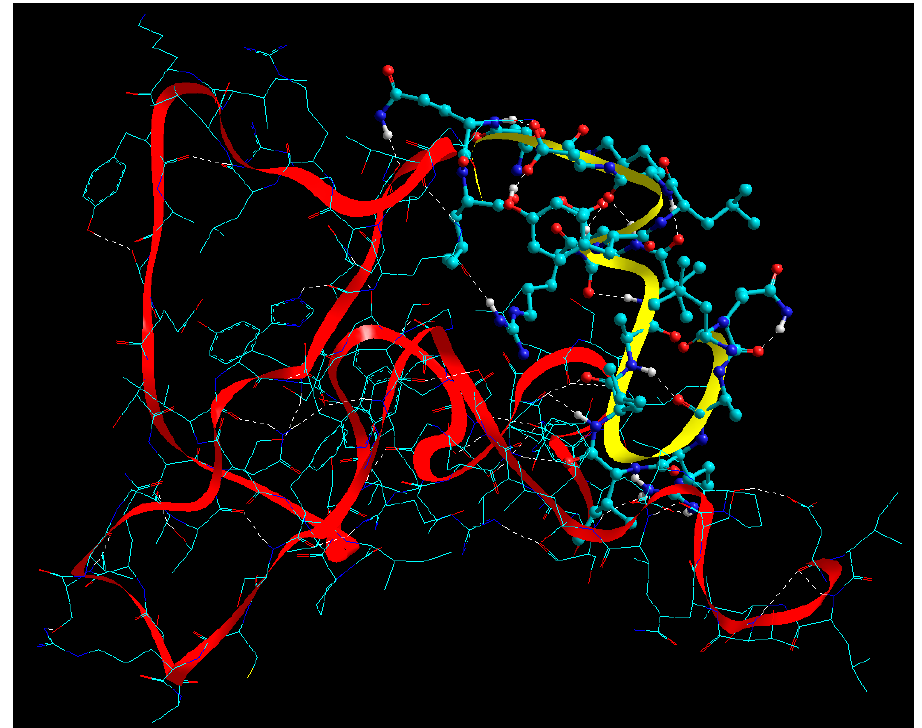
Figure 6. Visualization of geometrical preferences and functional interactions between BSA (yellow ribbon rendering) in complexation with the CET Chain A (red ribbon rendering) after molecular mechanics simulations in vacuum. Colour codes: C (cyan), O (red), N (blue) and H (white).